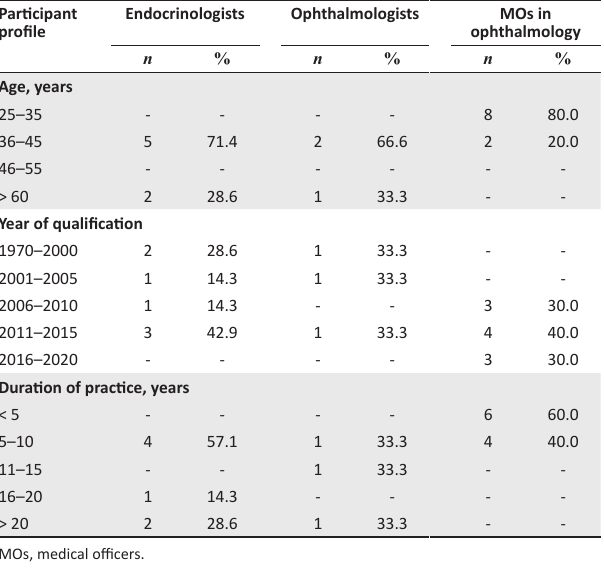
TABLE 2: Age, year of qualification and duration of practice. Participant profile